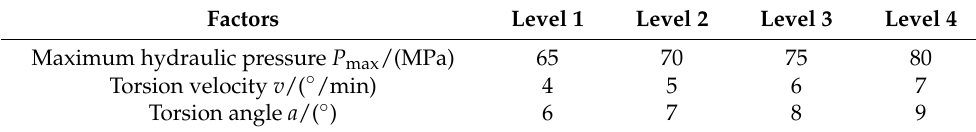
Table 3. Factors and levels of orthogonal torsion experiment.